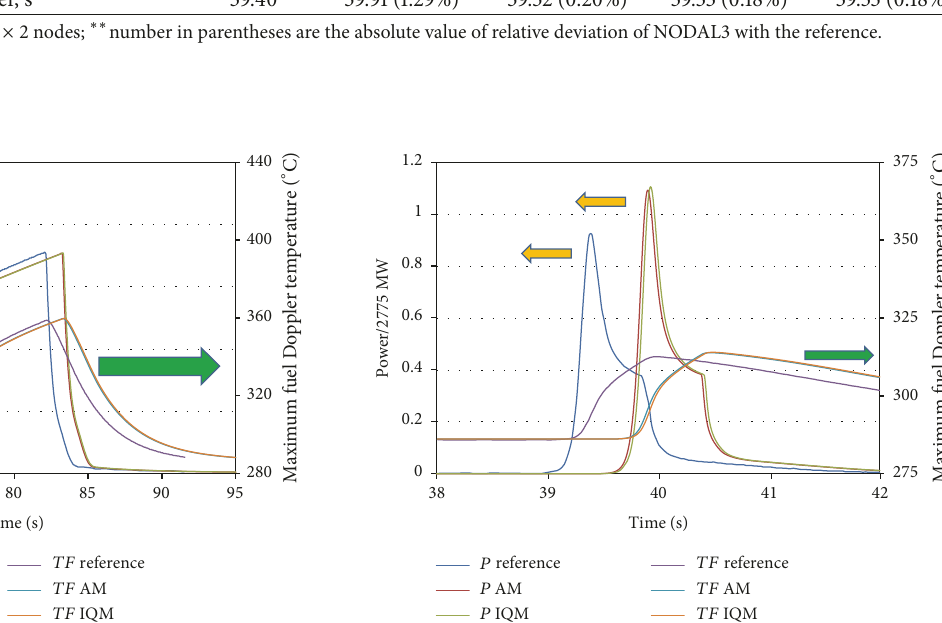
Figure 3: Fission power ( 𝑃 ) and average core Doppler temperature ( 𝑇 𝐹 ) distributions for Case A.